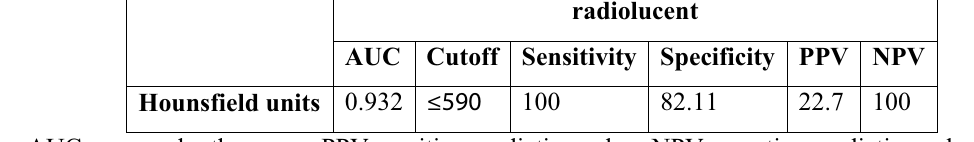
Table 4 Multiple linear regression analysis to assess the most significant predictors of stone composition